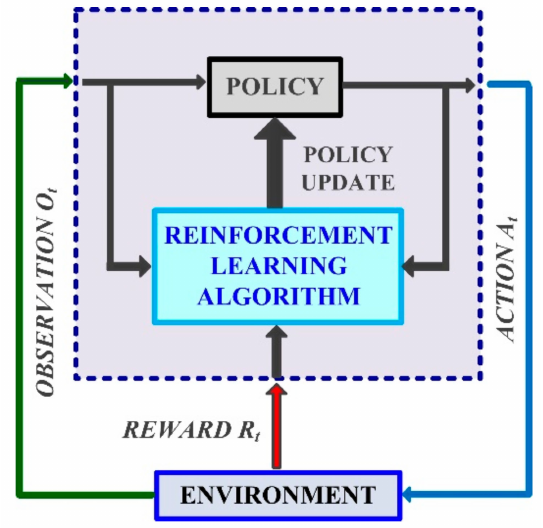
Figure 9. Block diagram of the RL for process